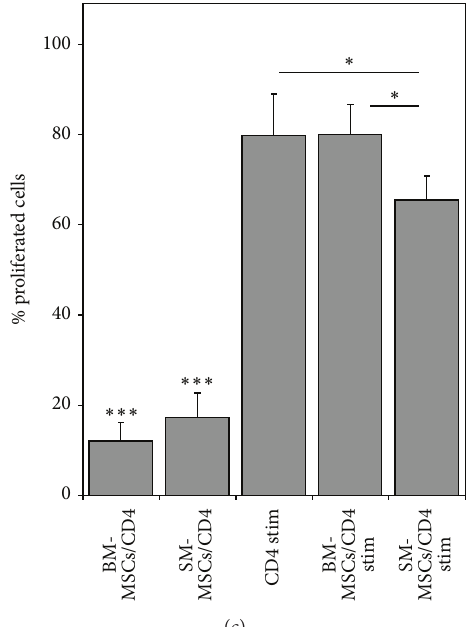
Figure 4: Evaluation of MSC/CD4+ T-cell interaction upon T-cell stimulation. (a) Representative photographs at d2, d4, and d5 of coculture for bone-marrow (BM) and synovial membrane (SM) derived MSCs are displayed. Index: 100 𝜇 m. (b) Representative histograms from one CFSE assay (total triplicate assays 𝑛 = 5 ) for unstimulated CD4+ T-cells, unstimulated CD4+BM-MSC and SM-MSC cocultures, and the respective CD3/CD28 stimulated cultures. (c) The histogram displays the mean percentage of proliferated cells in five triplicate CFSE assays (see Methods for gating). ∗ 𝑝 < 0.05 and ∗∗∗ 𝑝 < 0.001